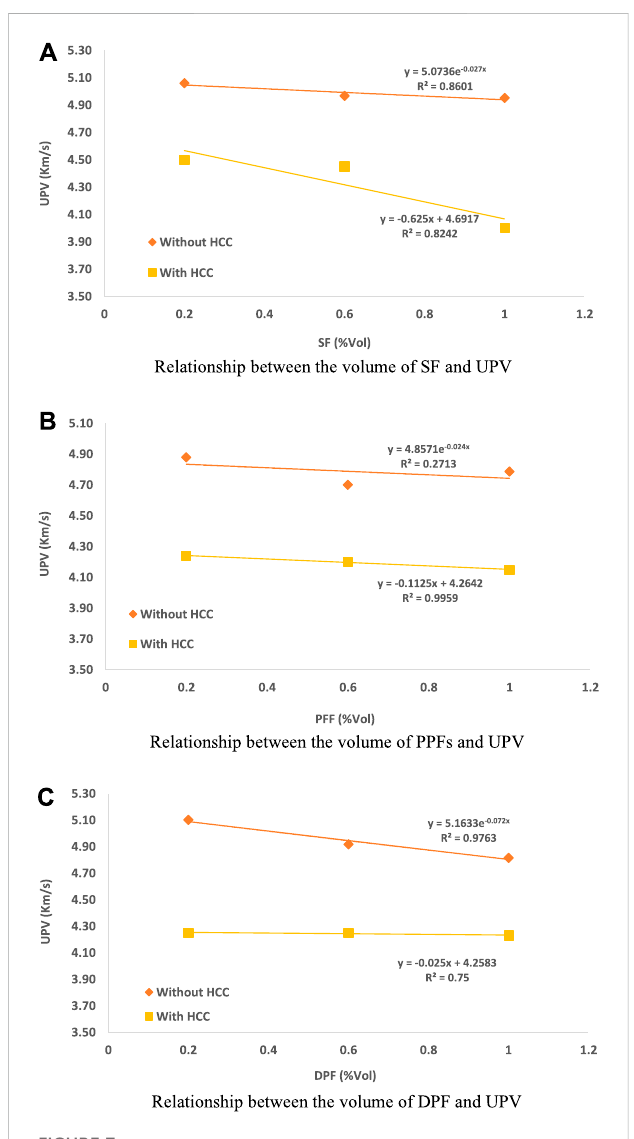
FIGURE 7 Relationship between the volume and UPV of SF, PPF, and DPF. (A) Relationship between the volume and UPV of SF. (B) Relationship between the volume and UPV of PPF. (C) Relationship between the volume and UPV of